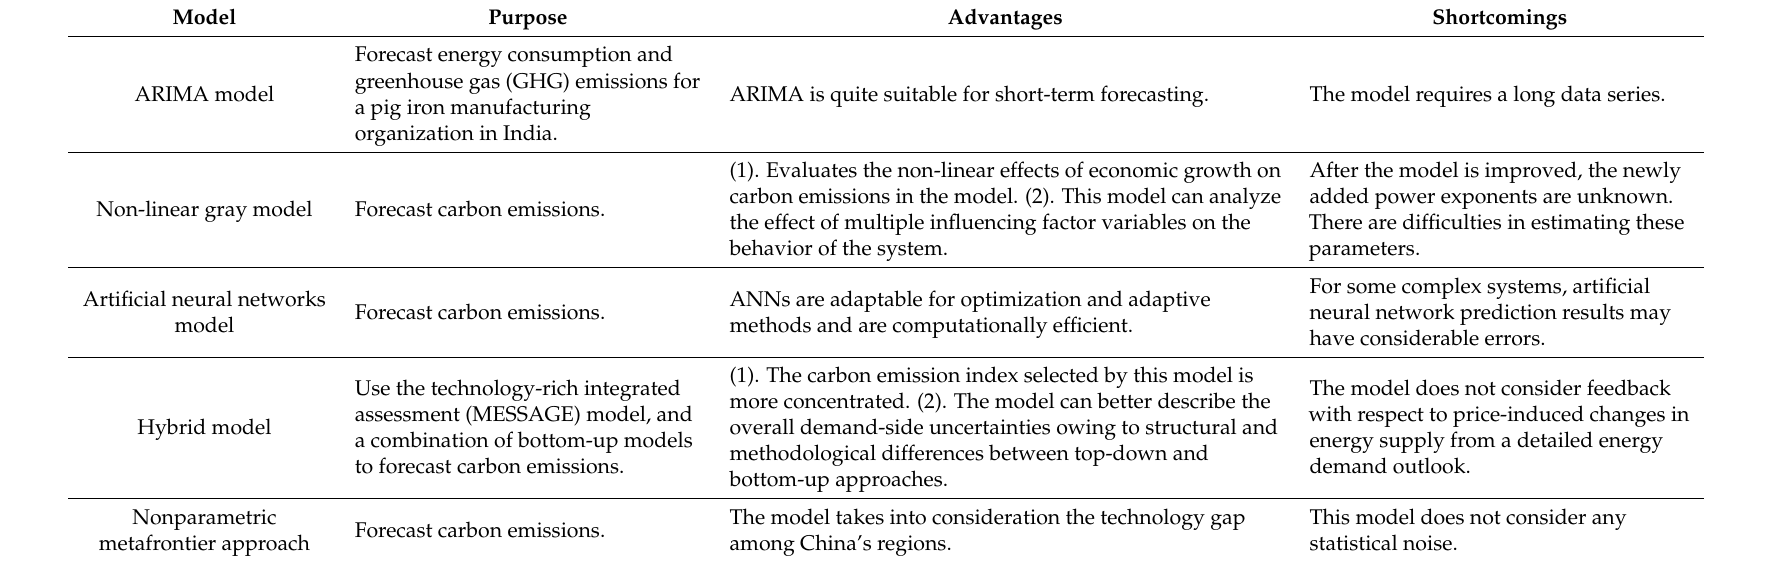
Table 1. Summary of each model’s advantages and